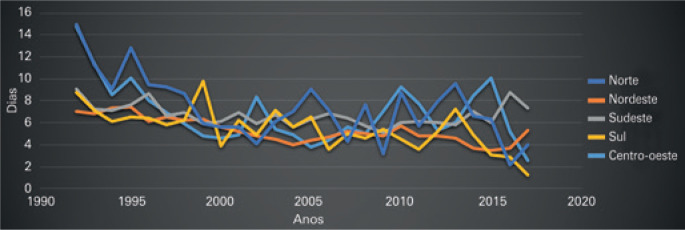
Tempo de internação devido ao diagnóstico de câncer de pênis, por regiões geográficas brasileiras, no Sistema Único de Saúde, de 1992 a 2017